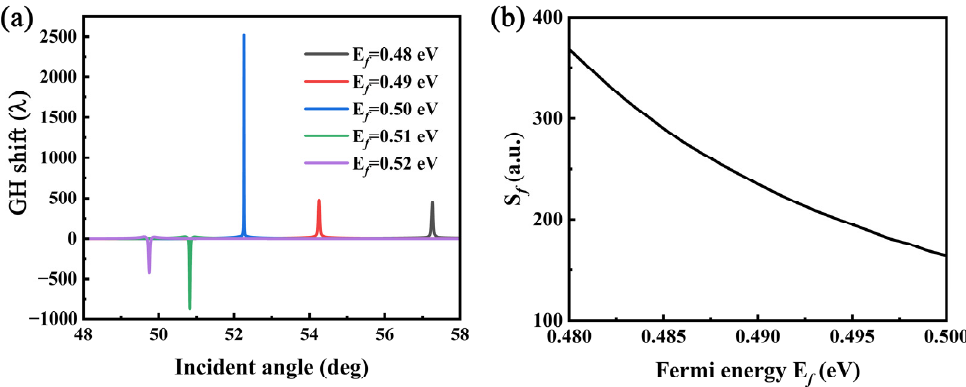
Figure 8. ( a ) Dependence of the GH shifts on the coupling structure at different E f for DSM. ( b ) Sensitivity as a function of E f .